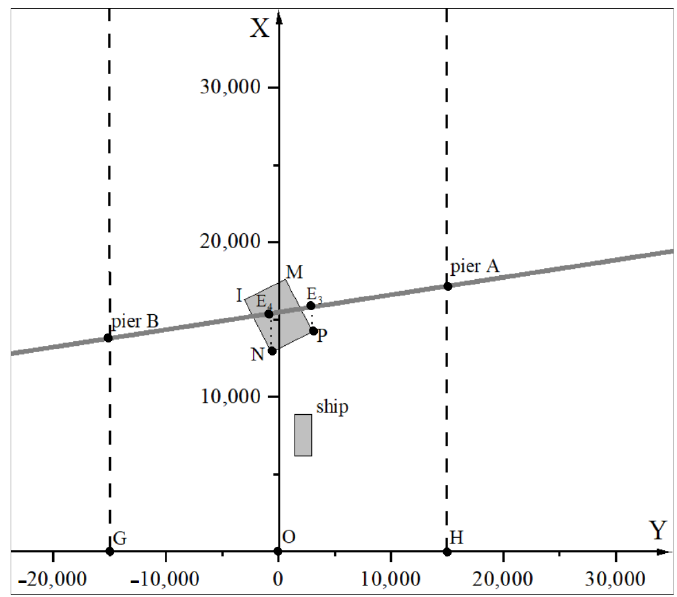
Figure 5. The pier IMPN’s diagram of bridge piers between AB.